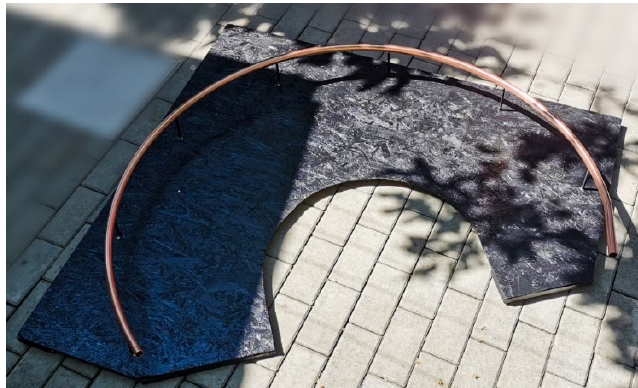
Figure 3. The rail fastened on the support board.